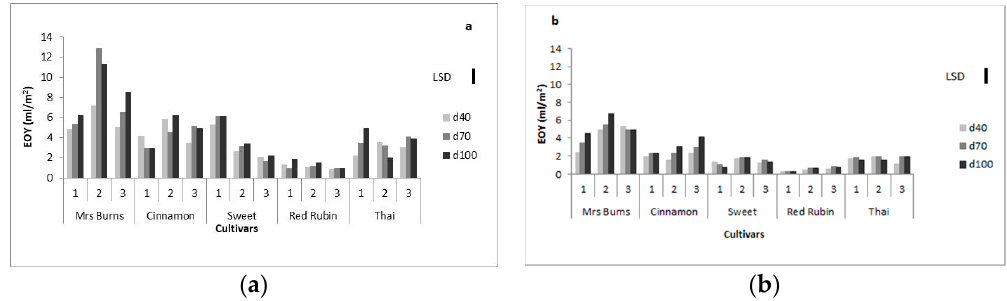
Figure 3. Essential oil yield (EOY) of the five basil cultivars during the three growing stages (where 1 is for the initiation of flowering, 2 is for the full bloom, 3 is the end of flowering) at the three irrigation levels (d 40 , d 70 , and d 100 ) for the two growing seasons 2015 ( a ) and 2016 ( b ). Data presented are mean values; vertical bar corresponds to the least significant difference (LSD).